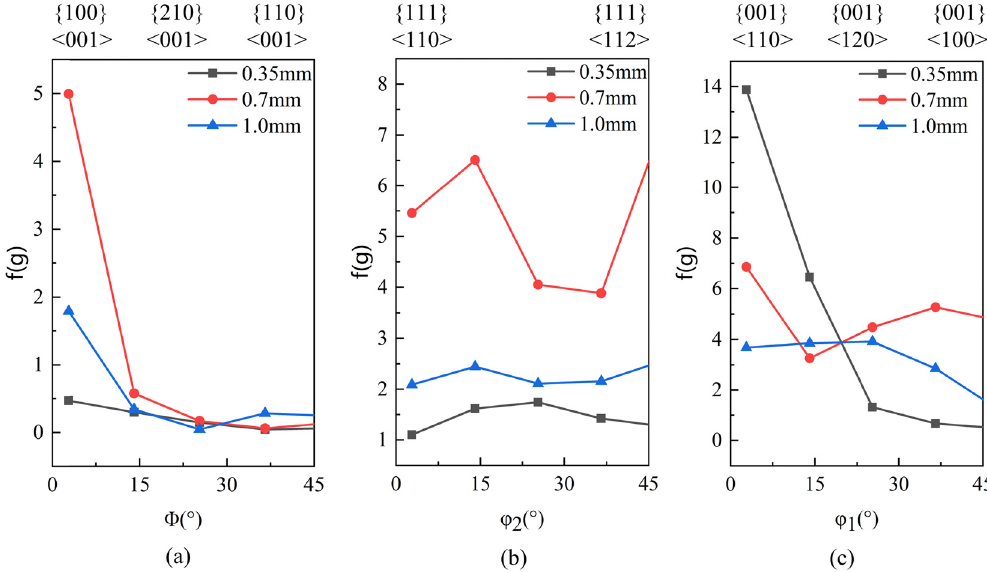
Figure 10: Distribution diagram of orientation lines of Y - free specimen: ( a ) η orientation line; ( b ) γ orientation line; ( c ) λ orientation line.